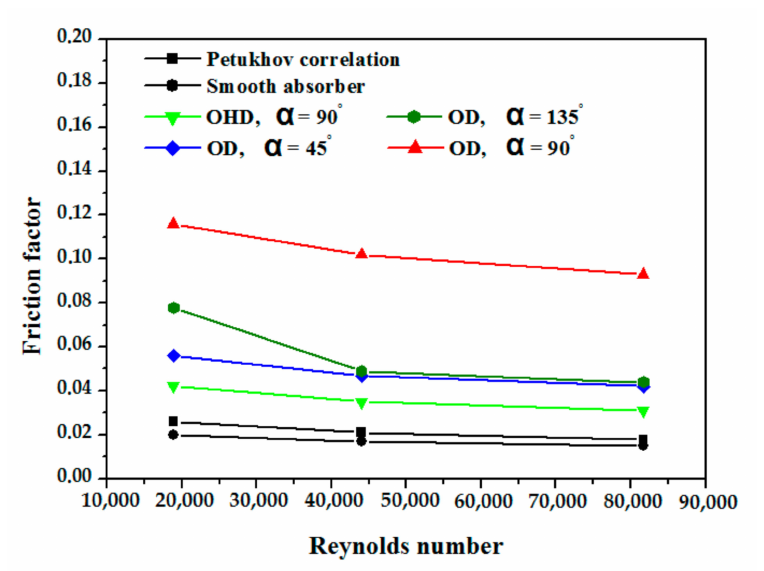
Figure 9. Variation in absorber tube’s friction factor vs. Reynolds number (P/D = 3). Comparing the friction factor derived in this study in the smooth absorber with the Petukhov correlation shows that it corresponds to reality. The same figure demonstrates that the highest and smallest discrepancies between our numerical results and Petukhov’s correlation are 15% and 11%, respectively. On sectional planes (y-axis and z-axis) over the length of the absorber tube with and without obstructions, Figure 10 depicts the average temperature distribution for heat transfer fluid. The temperature reaches its maximum at the exit, and higher temperatures are obtained in the absorber tube with obstruction discs ( α = 90 ◦ ) case than in the other cases.